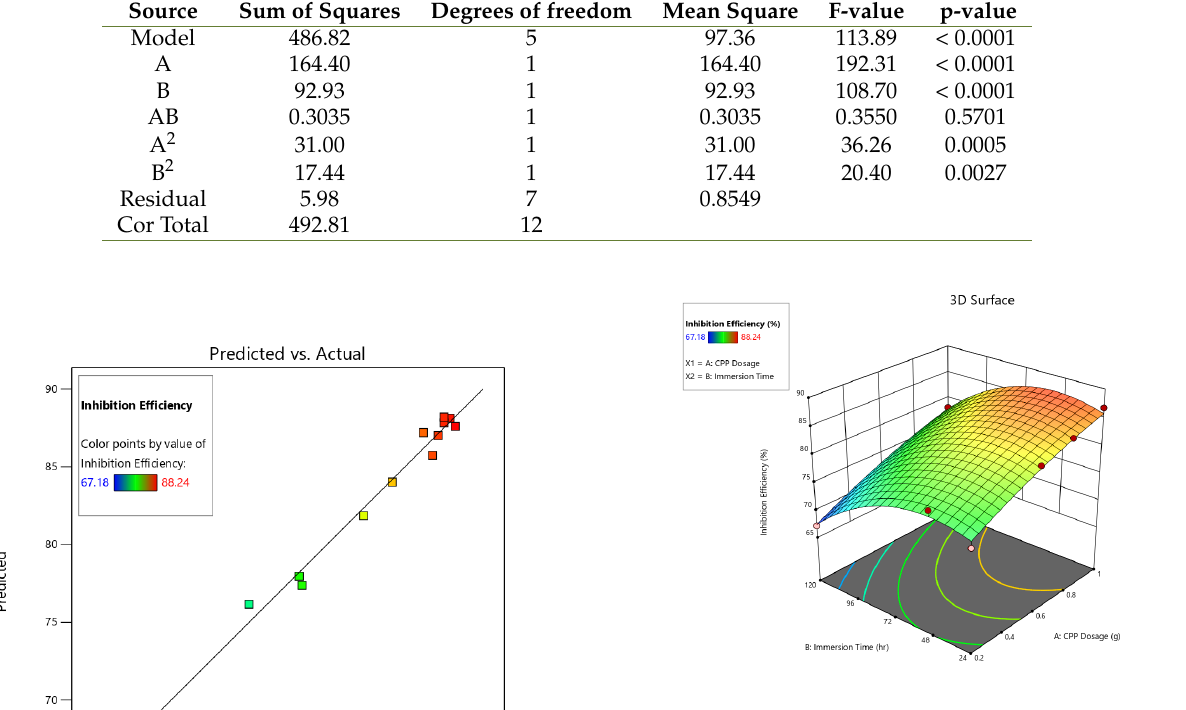
Fig. 7. 3D response surface plots of immersion time and CPP dosages on the inhibition